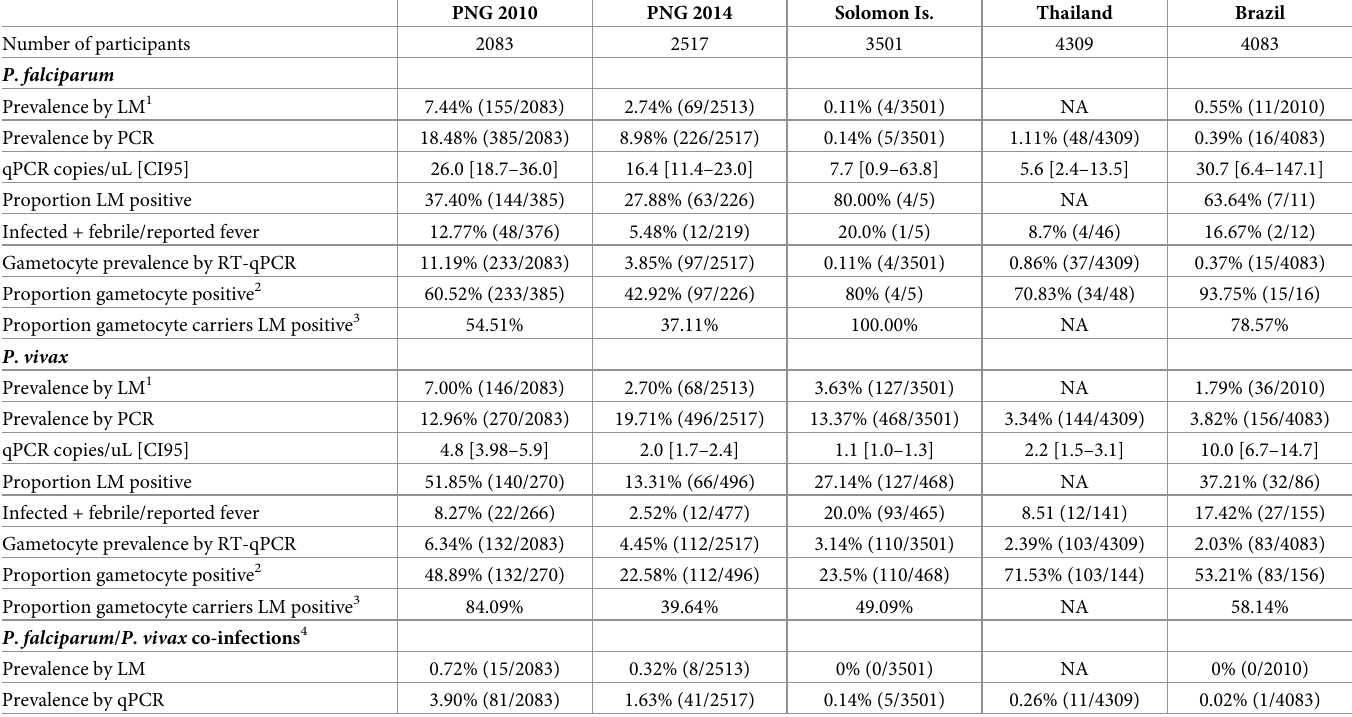
Table 2. Parasite and gametocyte prevalence by LM and qPCR and RT-qPCR, and parasite densities by